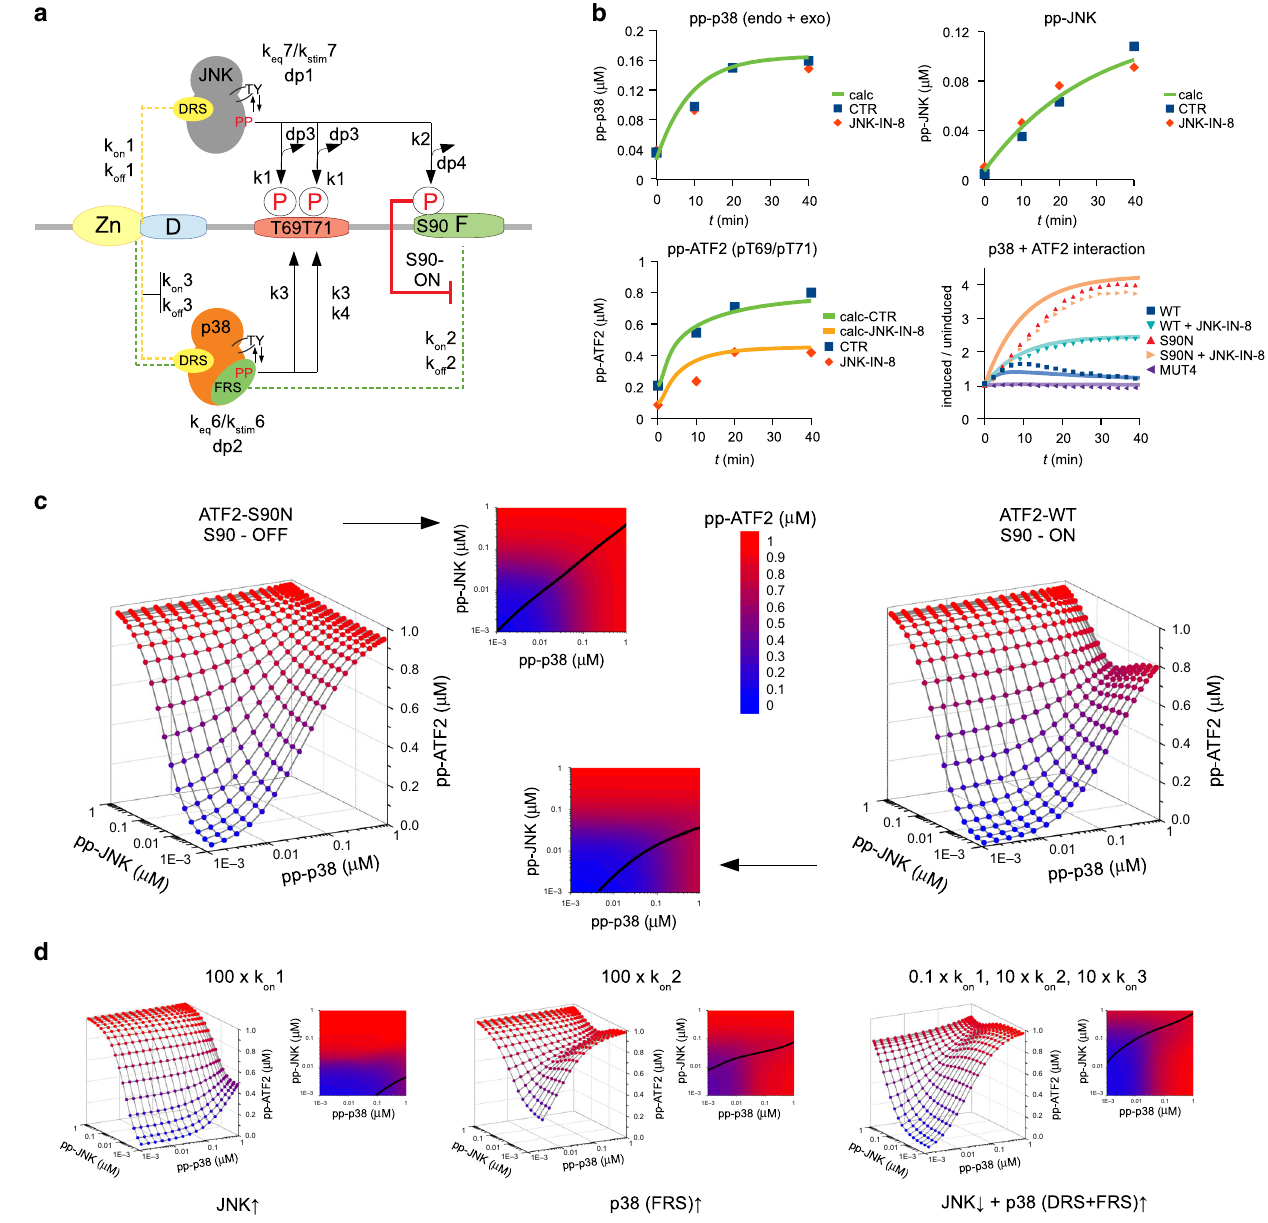
Fig. 7 Modeling the impact of JNK and/or p38 MAPK pathway fl ux on ATF2 TAD phosphorylation. a Mechanistic scheme of MAPK mediated ATF2 TAD phosphorylation. The panel shows the architecture of the rule-based BioNetGen model. Dashed lines represent binding rules (with k on and k off ) and lines with an arrow indicate enzymatic reactions (with reaction rates of kinases, k, and phosphatases, dp). Signaling is initiated by increasing k6 and k7 activity (k eq 6 → k stim 6, k eq 7 → k stim 7). D: D-motif; DRS: D-motif recruitment site; F: SPFENEF or F-motif; FRS: F-motif recruitment site; S90-ON: S90 is phosphorylated by JNK blocking p38(FRS):F-motif binding. P: phosphorylation on T69, T71 or S90. b Determination of model parameters. HEK293T cells were stimulated by anisomycin and pp-JNK, pp-p38 and pp-ATF2-T69/T71 were monitored in western-blots (JNK-IN-8: in the presence of JNK inhibitor; CTR: control, without the inhibitor; “ calc ” denotes simulated plots). The parallel p38-ATF2 NanoBit assay signal was also used to determine the parameters that could not be directly measured (i.e., k stim 6, k stim 7, dp1, dp2, dp3 and dp4). c Simulated ATF2 TAD phosphorylation levels 40 min after stimulation. The model was stimulated by different k stim 6 and k stim 7 (evenly distributed from 10 − 6 to 10 − 2 in the logarithmic scale). 3D plots show ATF2 TAD phosphorylation as the function of different amounts of pp-p38 and pp-JNK (from 0.001 to 1 µ M; from blue to red, respectively), where pp-JNK and pp-p38 levels denote the activated state of the MAPKs. (Total in-cell MAPK and ATF2 concentrations were set to 1 µ M for each protein.) ATF2-S90N S90-OFF: ATF2 TAD with a non-phosphorylatable serine to asparagine replacement at 90 (invertebrates); ATF2-WT S90-ON: results of the simulation with intact vertebrate ATF2 TAD. 2D panels show projections of the corresponding 3D plots. Black line indicates where pp-ATF2 level is equally sensitive to the activation of both MAPKs. The region above this line corresponds to an area where pp-ATF2 is more sensitive to JNK, while the region below the line is more sensitive to changes in p38 pathway fl ux. d The impact of MAPK binding af fi nity and speci fi city on pp-ATF2 levels. JNK-ATF2 or p38-ATF2 binding af fi nities were arbitrarily changed in the model and the impact of these on pp-ATF2 level was simulated. Binding af fi nity was increased by 100-fold by increasing the k on (left and middle panels) or changed by 10-fold (lowered for JNK but increased for p38; right panel). Note that k off 1/k on 1, k off 2/k on 2, and k off3 /k on 3 describe the af fi nity of JNK(DRS)-, p38(FRS)-, and p38(DRS)-ATF2 TAD binding, respectively (FRS: F-motif recruitment site; DRS: D-motif recruitment